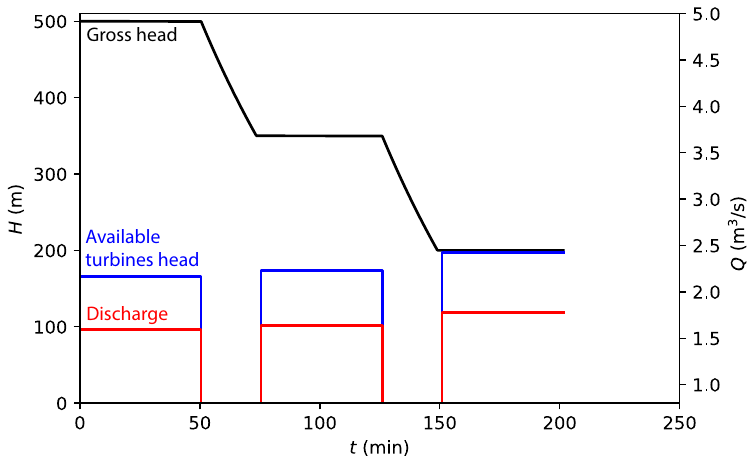
Figure 10. Time history of the gross head, available head and discharge of each Francis turbine operating at maximum efficiency for the given head (Scenario